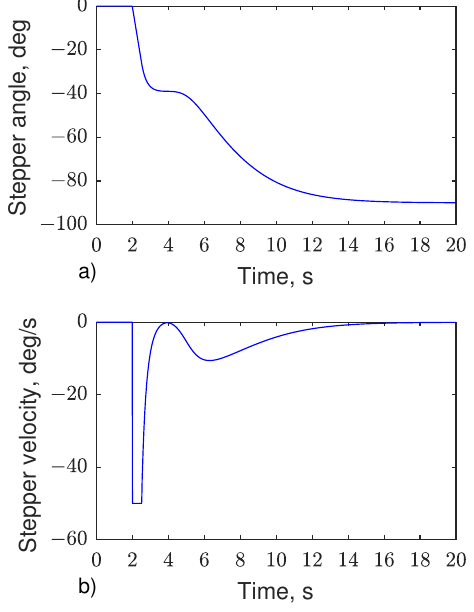
Figure 8. ( a ) Angle θ z and ( b ) rate ˙ θ z